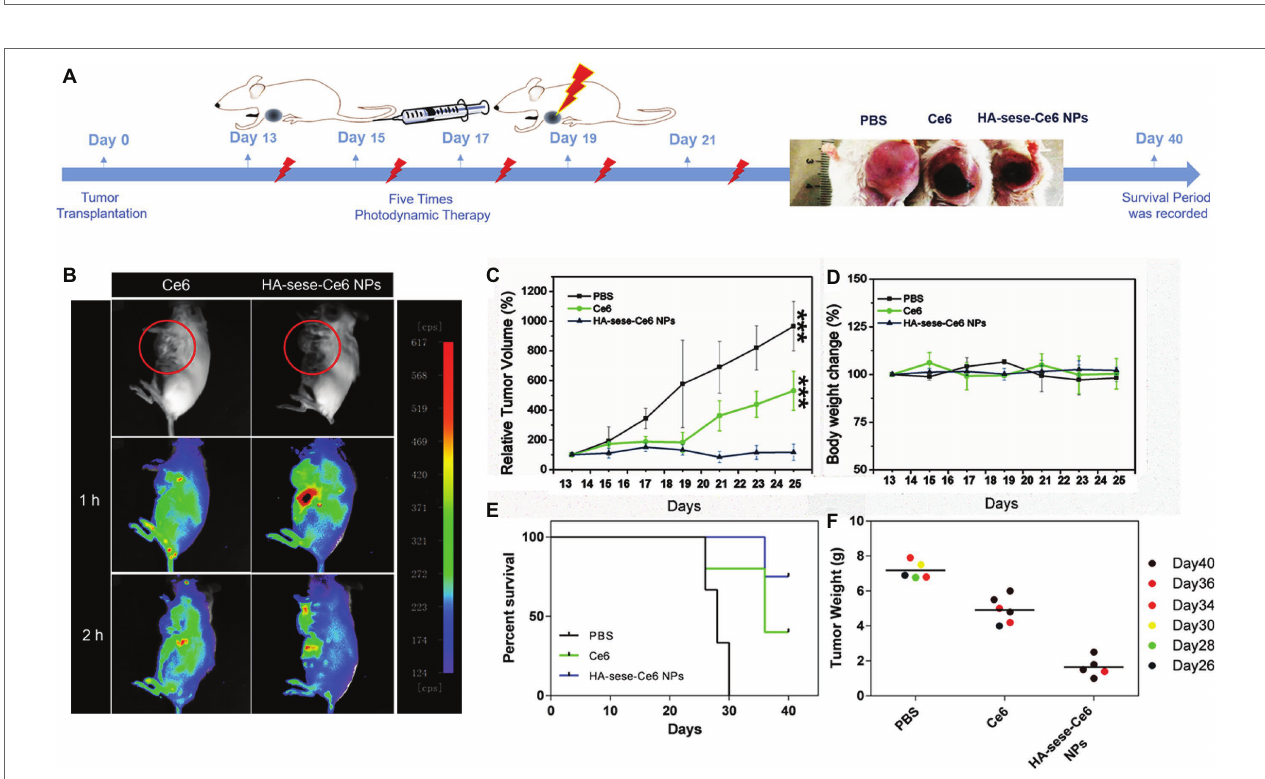
FIGURE 4 | Phototoxicity of 4T1 cancer cells treated with free Ce6 and HA-sese-Ce6 micelles, at equivalent concentrations (0.25–2 μM Ce6). ( Left ) Dark toxicity of 4T1 cancer cells treated with free Ce6 and HA-sese-Ce6 micelles, at equivalent concentrations (0.25–2 μM Ce6) ( Right